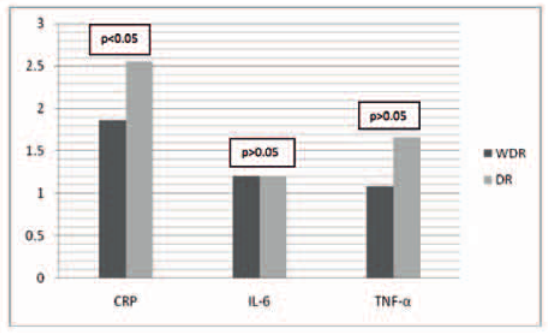
Figure 1. Infl ammatory cytokines and diabetic nephropathy. WDN – without diabetic nephropathy; DN – diabetic nephropathy